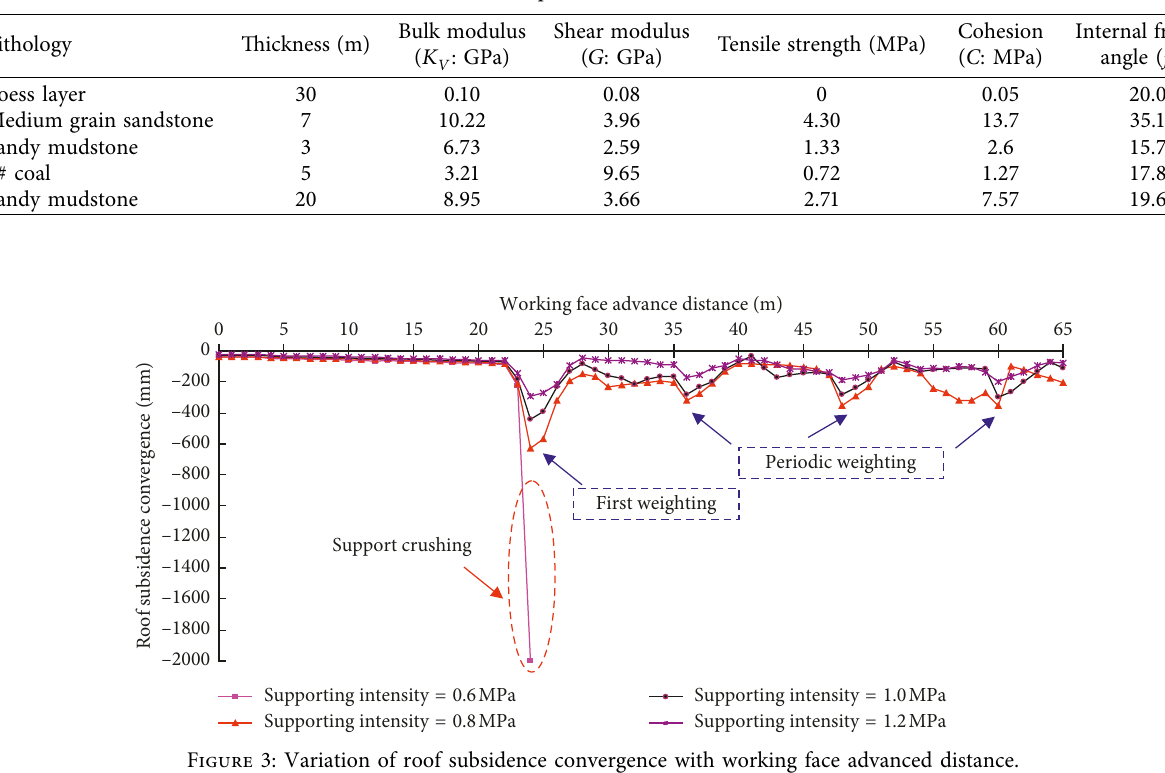
Table 2: Mechanical parameters of different rock